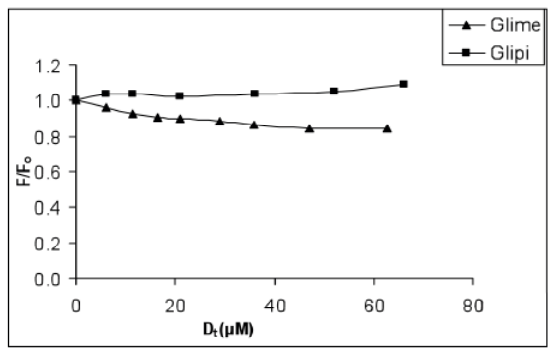
Figure 5. Relative fluorescence intensity of ANS in HSA-ANS complex as a function of drug concentration